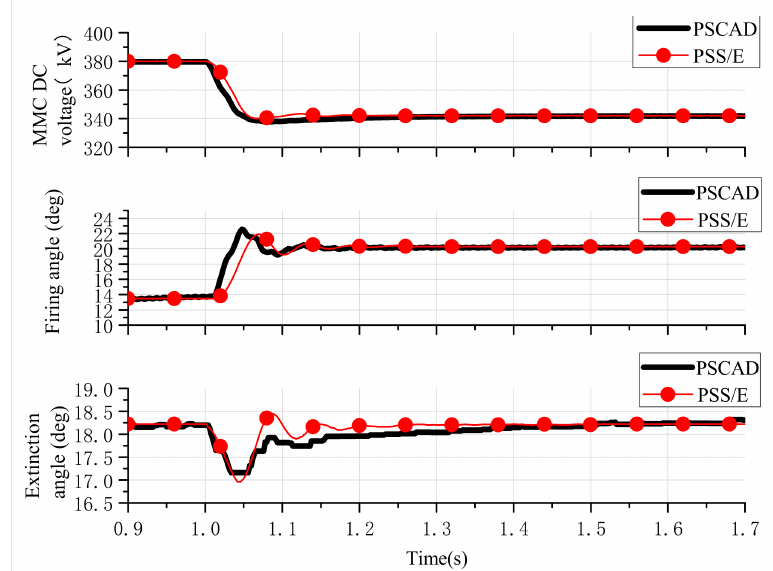
Figure 8. Dynamic response comparison between electromechanical model and electromagnetic